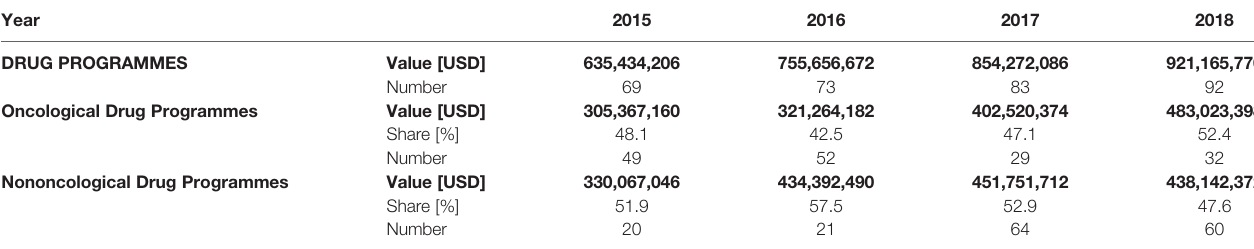
TABLE 2 | Reimbursement by drug programme type in years 2015-2018 in Poland